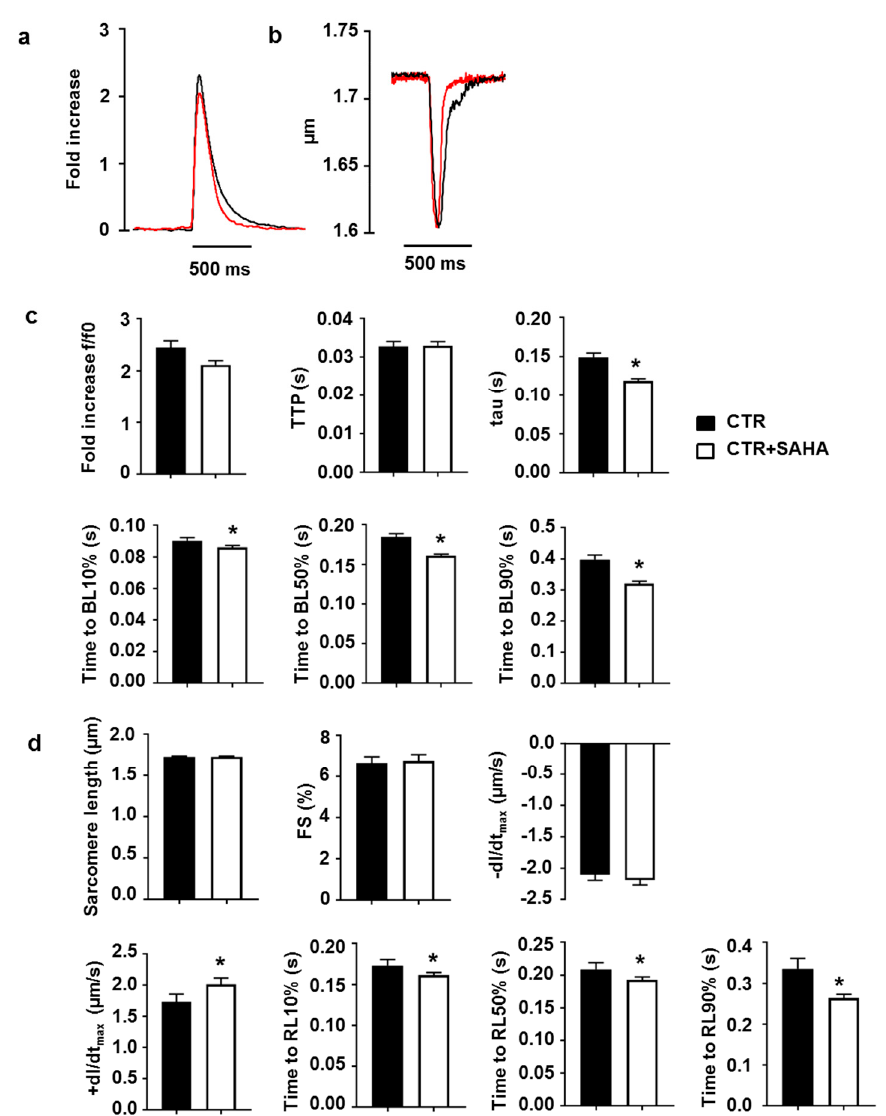
Figure 3. Effect of SAHA treatment on calcium transients and cell mechanics in CMs isolated from adult rat hearts. Representative examples of calcium transients ( a ) normalized traces: fold increase and sarcomere shortening ( b ) recorded from CTR (black line) and CTR+SAHA (red line) ventricular myocytes. ( c ) Calcium transient parameters: amplitude of calcium transient (expressed as calcium peak fluorescence normalized to baseline fluorescence, f/f0: fold increase), time to peak of the calcium transient (TTP), time constant of the rate of intracellular Ca 2+ clearing (tau), and recovery phase of Ca 2+ transients indicated as time to 10% (BL10), 50% (BL50) and 90% (BL90) of fluorescence signal decay. ( d ) Cell mechanics: diastolic sarcomere length and fraction of shortening (FS), maximal rates of shortening ( − dl/dt max ) and re-lengthening (+dl/dt max ), time of re-lengthening at 10% (RL10), 50% (RL50) and 90% (RL90). All data are presented as mean ± SEM and analysed using General Linear Model (GLM) ANOVA for repeated measurements ( n = 45 untreated CMs, n = 70 CMs treated with SAHA): * p < 0.005 vs. CTR.